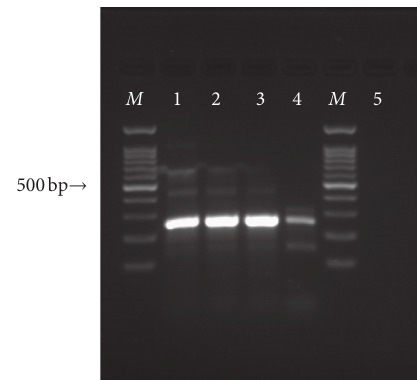
Figure 2: Agarose gel electrophoresis of the seminested PCR products of the ITS1-5.8s-ITS2 region. Line M, 100bp molecular marker; lines 1 and 2, positive control ( Aspergillus niger) ; line 3, sample isolated from the patient in the current study; line 4, 1/10 diluted patient sample ( Aspergillus niger ); line 5, negative